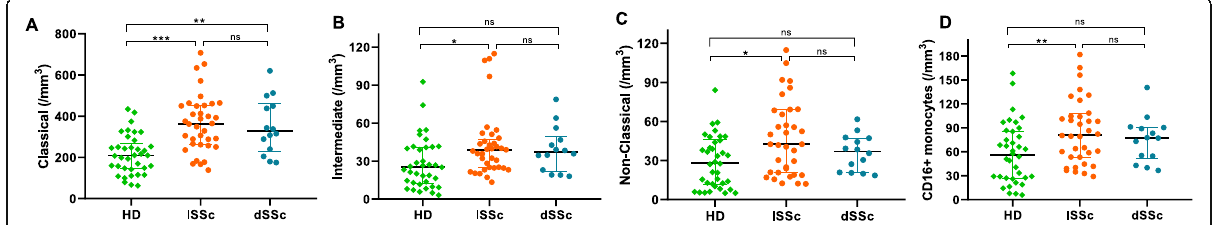
Fig. 2 Monocyte subpopulations according to their membrane expression of CD14 and CD16 in systemic sclerosis patients with limited (lSSc) ( n = 36) and diffuse (dSSc) ( n = 14) subtypes, and in healthy controls (HC) ( n = 38). The absolute count of all monocyte subpopulations - classical a , intermediate b and non-classical c - is increased in lSSc compared to HC. d When analyzing intermediate and non-classical monocytes as a single group of CD16+ monocytes, their absolute value is increased in lSSc compared to HC. * p < 0.05; ** p < 0.01; *** p <